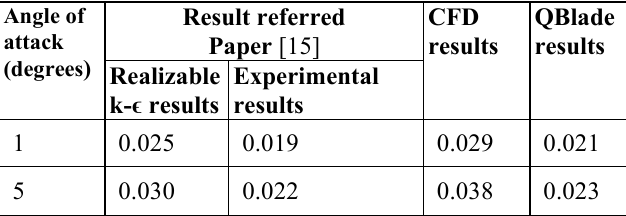
Table 3. Validation results for